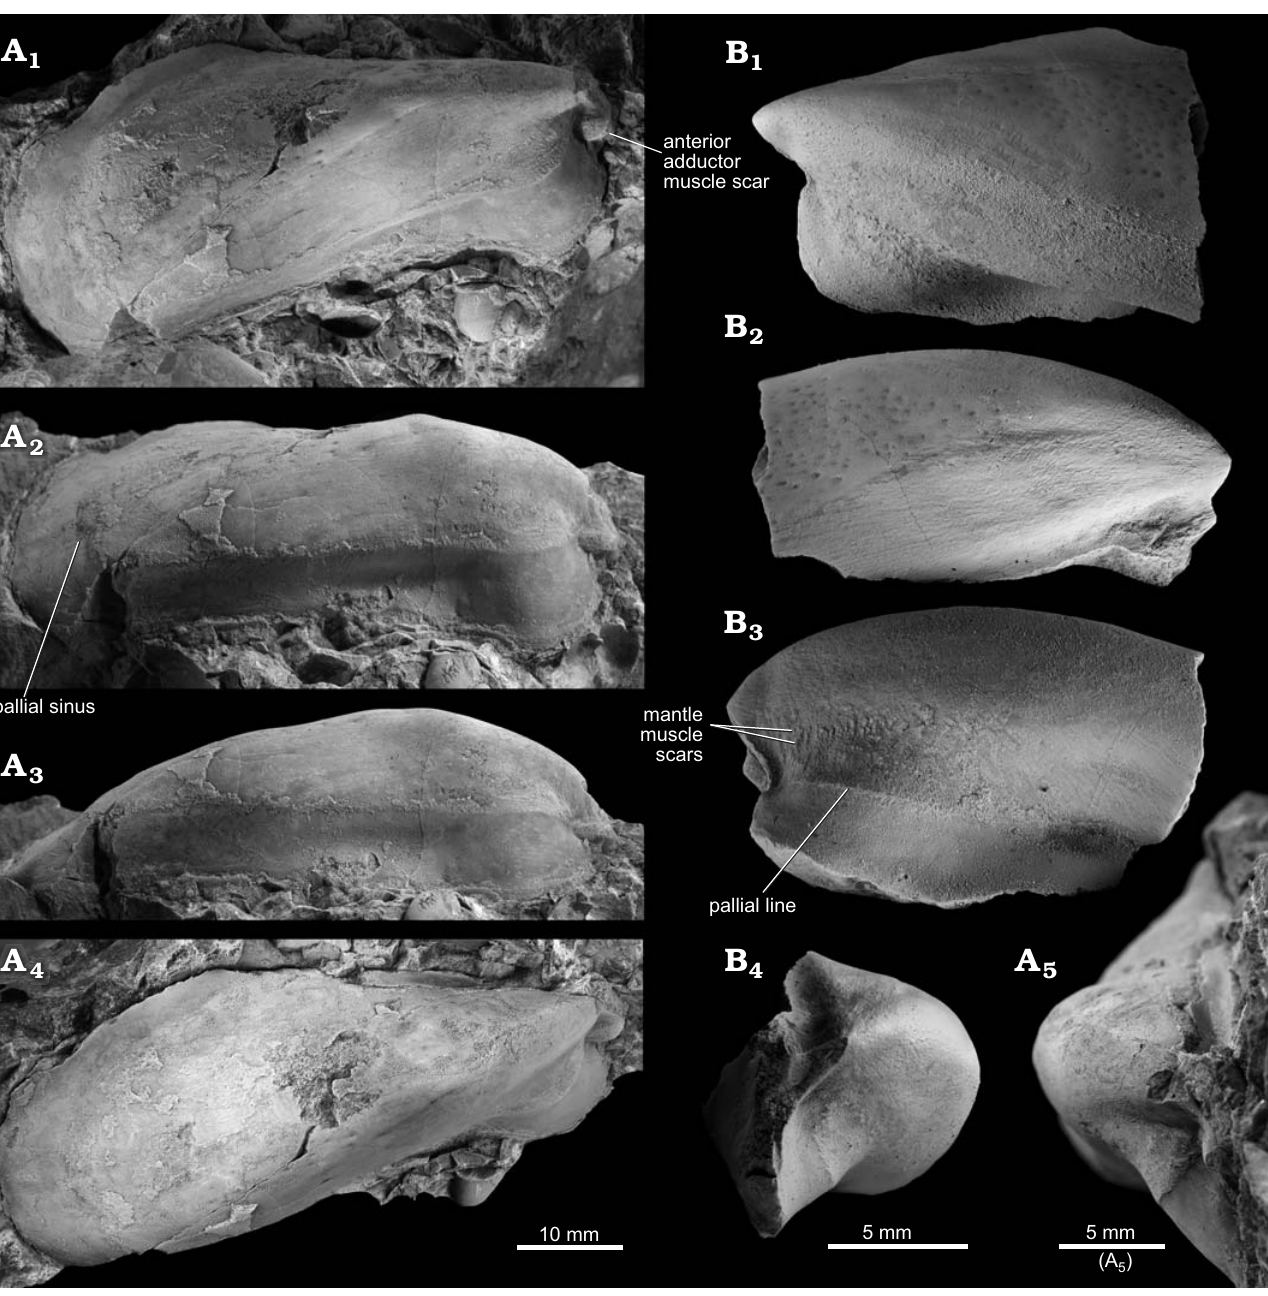
Fig. 4. The kalenterid bivalve Kasimlara kosuni gen. et sp. nov. from the late Carnian, Late Triassic Terziler III seep deposit in southern Turkey. A . Mo184061, holotype, large internal mold of right valve; lateral (A 1 ), lateral-ventral (A 2 ), ventral (A 3 ), lateral-dorsal (A 4 ), and anterior (A 5 ) views. B . Mo184062, internal mold of anterior part of left valve; showing tubercles (as pits in the mold) on the lateral side of the shell’s interior (B 1 ), fine radial striation on the dorsal inner side of the shell (B 2 ), ventral view on the dorsal inner side of the shell (B 3 ), anterior side, note the strong inflation of the shell (B 4